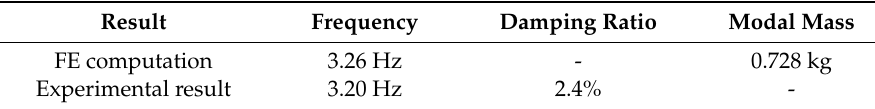
Figure 6. Vertical response and its Fast Fourier transform (FFT) amplitude of the submerged pipeline in seawater environment: ( a ) free vibration response; ( b ) FFT amplitude. Table 2. Modal parameters of the pipeline structure.